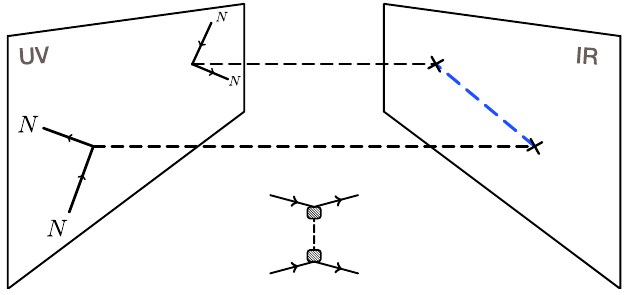
Figure 4 . Diagram in 5D anti-de Sitter space giving rise to the emergent force. Blue line shows the propagator of the IR brane localized (cid:12)eld. Crosses indicate mass